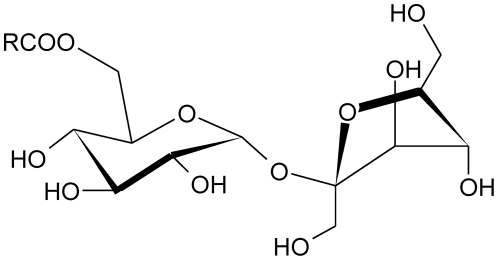
Chemical structure of studied sucrose monoesters, R = C7H15 Octyl acid derivative (MOS), R = C9H19 Capric acid derivative (MCS), R = C11H23 Lauric acid derivative (MLS), R = C13H27 Myristic acid derivative (MMS), R = C15H31 Palmitic acid derivative (MPS), R = C17H35 Stearic acid derivative (MSS).